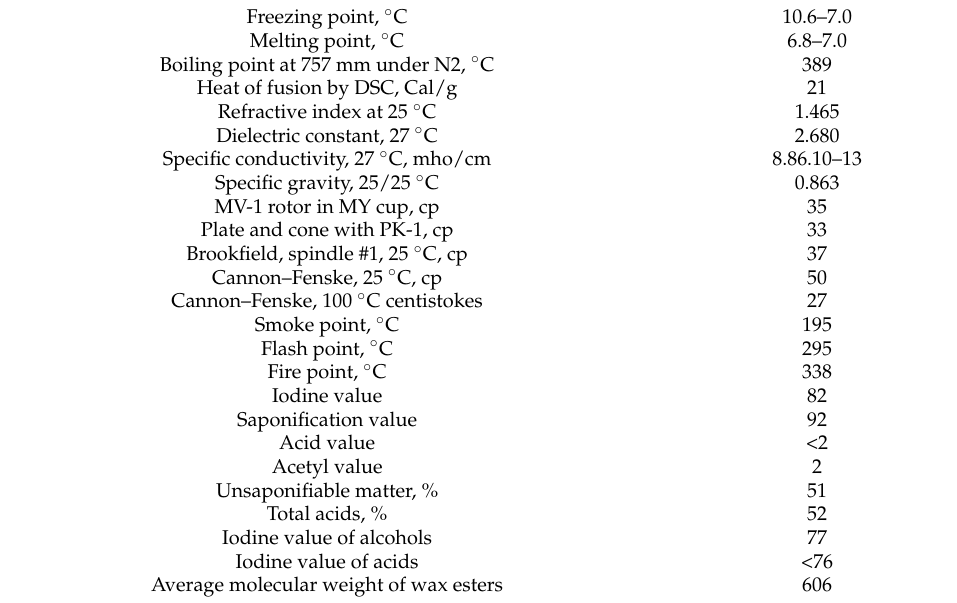
Table 6. Some physical properties of jojoba oil as reported in the literature